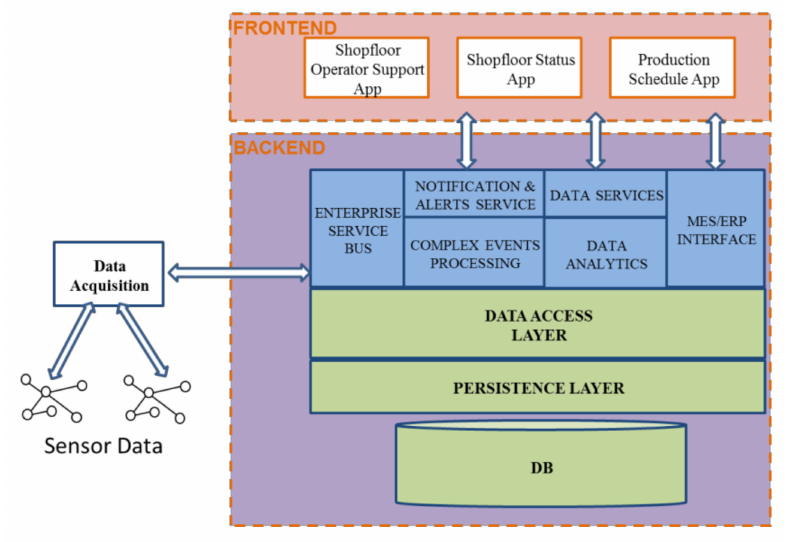
Figure 1. System